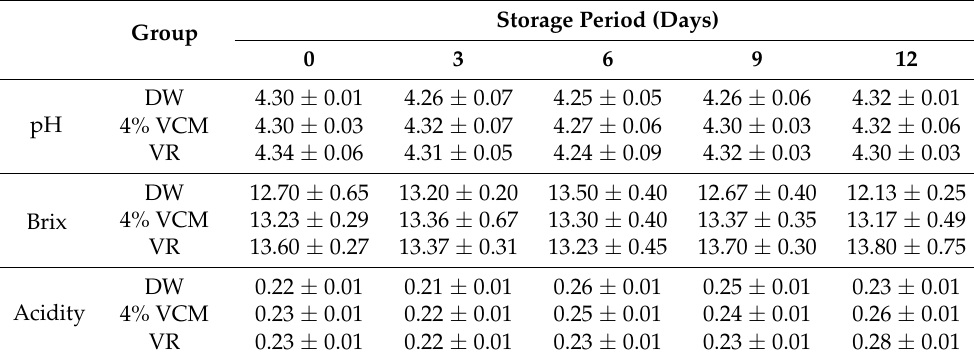
Table 2. Changes in the pH, Brix, and acidity of freshly cut apples.